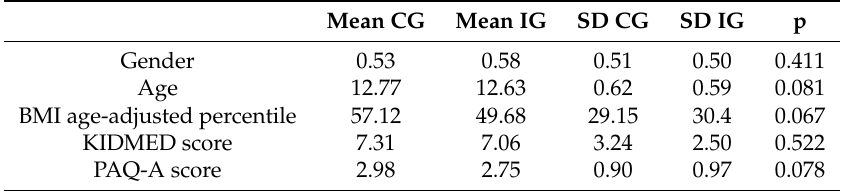
Table 1. Gender, age, BMI age-adjusted percentile, KIDMED score and PAQ-A score in intervention group (IG) and control group